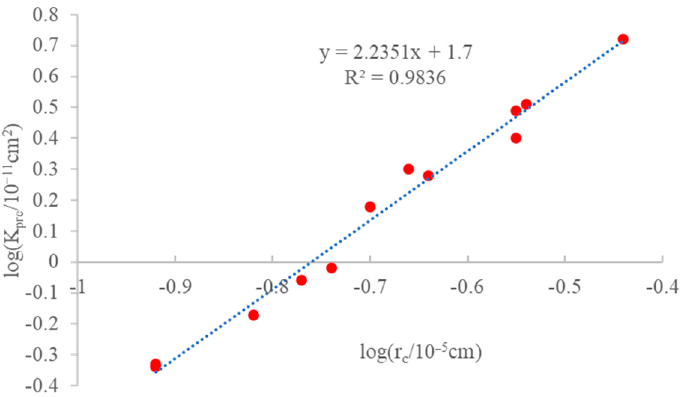
Figure 4. Relationship of predicted permeability and critical pore diameter.